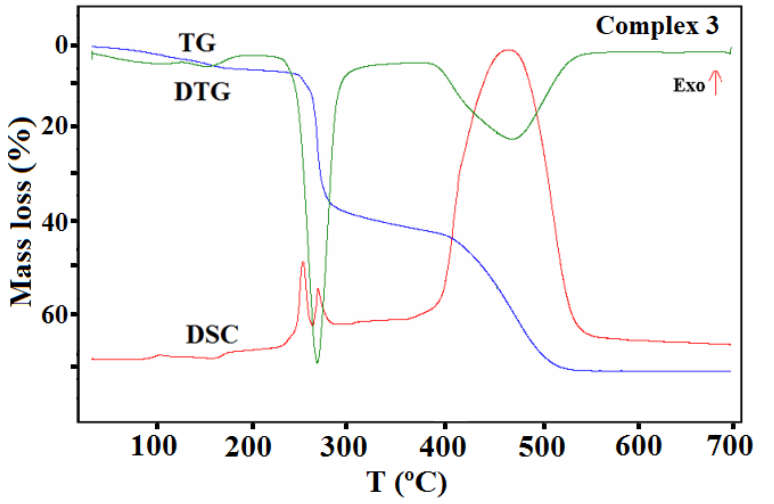
Figure 14. TG, DTG, and DCS curves of thermal decomposition of complex 3 in air.